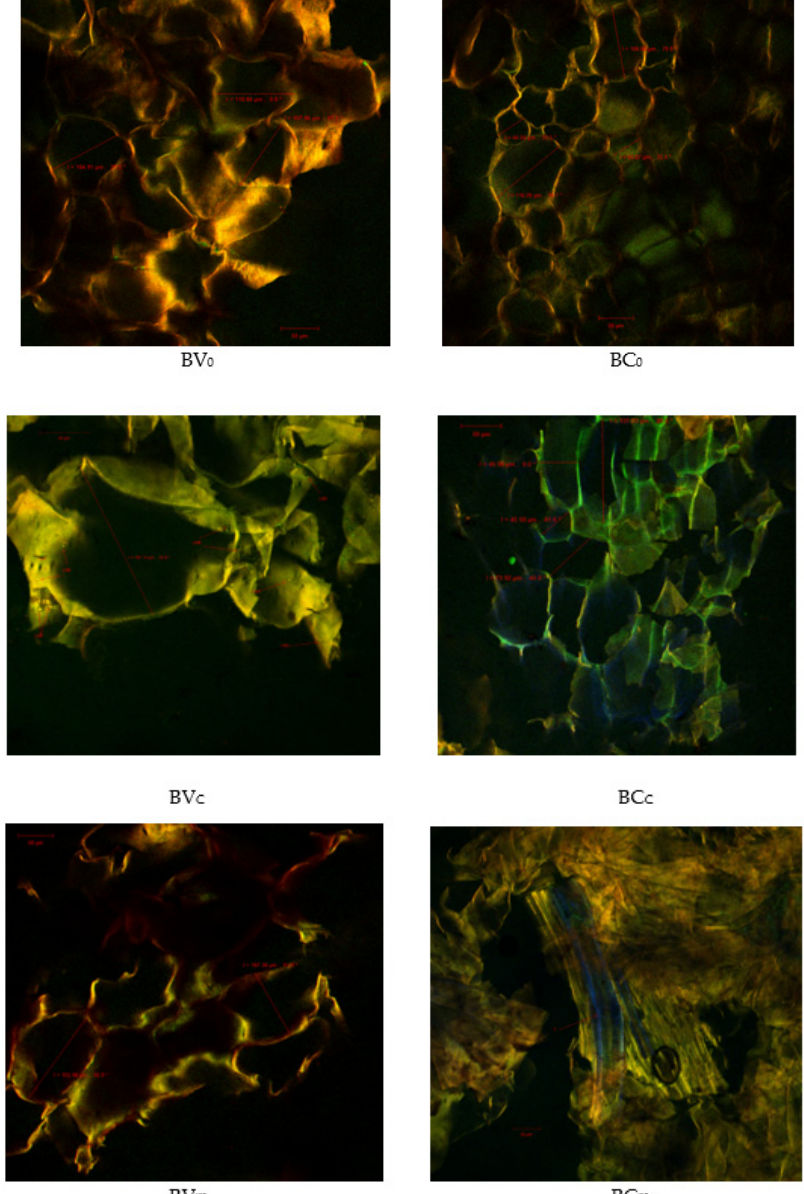
Figure 2. Confocal laser microscopy images of fresh and reconstituted red beetroot purée samples obtained with objective lenses of 20x: BV 0 —fresh sample of Beta vulgaris L. var. vulgaris ; BC 0 —fresh sample of Beta vulgaris L. var. cylindra ; BV C , BC C —red beet purée dried by convection method; BV IR , BC IR —red beet purée dried by infra-red (IR) method; scale bar 50 µm.